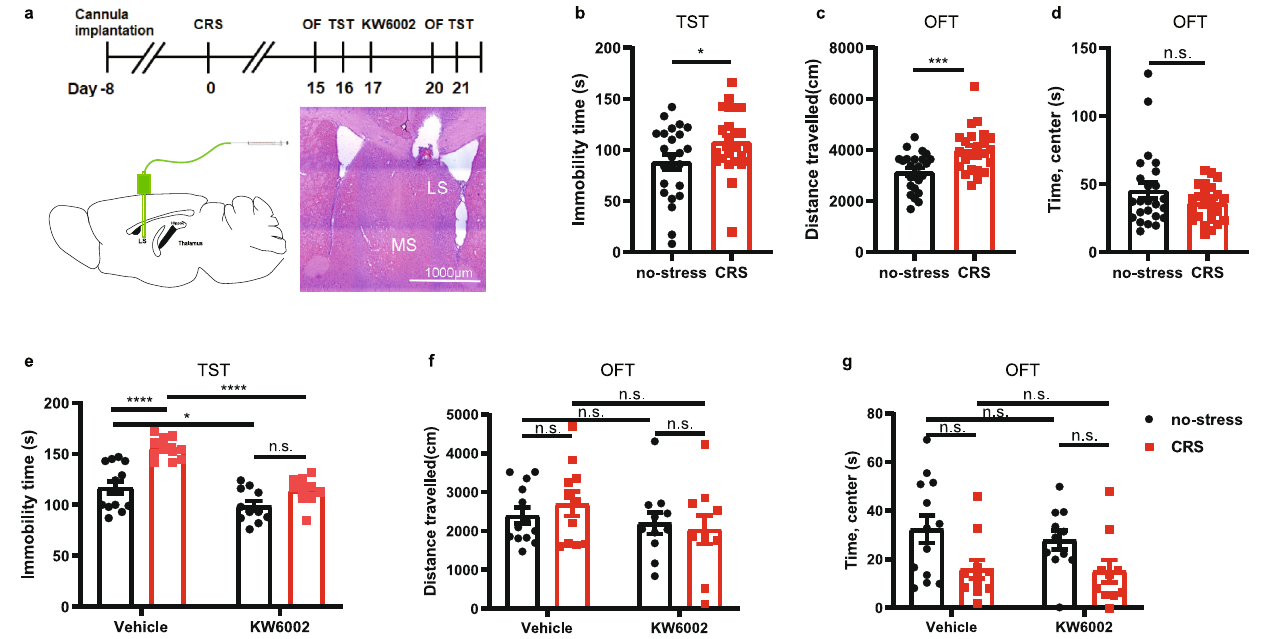
Fig. 9 | Focal pharmacological inactivation of A 2A R in the lateral septum (LS) affords an anti-depressant-like phenotype. a Schematic protocol for investigat- ingtheroleoftheA 2A RantagonistKW6002toreversetheCRS-induceddepressive phenotypes. Hematoxylin and eosin (HE) staining showing the position of the cannulas. Scale bar: 1000 μ m. b – d After con fi rming that the mice subject CRS displayedadepressive-like behaviorsin the tailsuspension test (TST)( n =24mice/ group, Unpaired t test, p =0.0476, t(46)=2.035) b and in the open fi eld test (OFT) ( c : n =24 mice/group, Unpaired t test, p =0.0006, t(46)=3.671; d: n =24